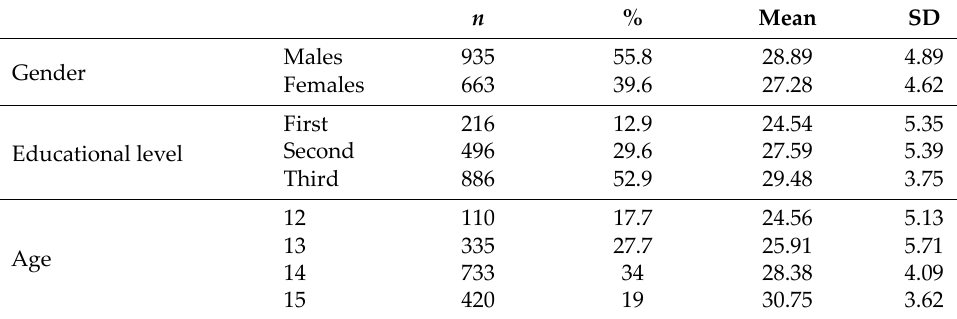
Table 1. The characteristics of the study sample ( n =